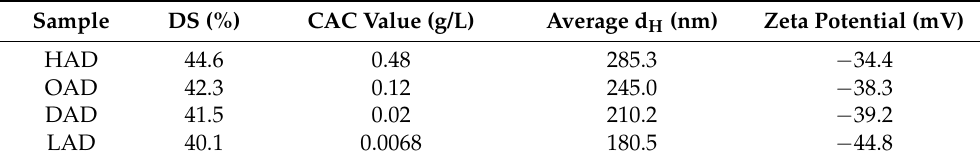
Table 2. Comparison of performance parameters of AAD with different hydrophobic side